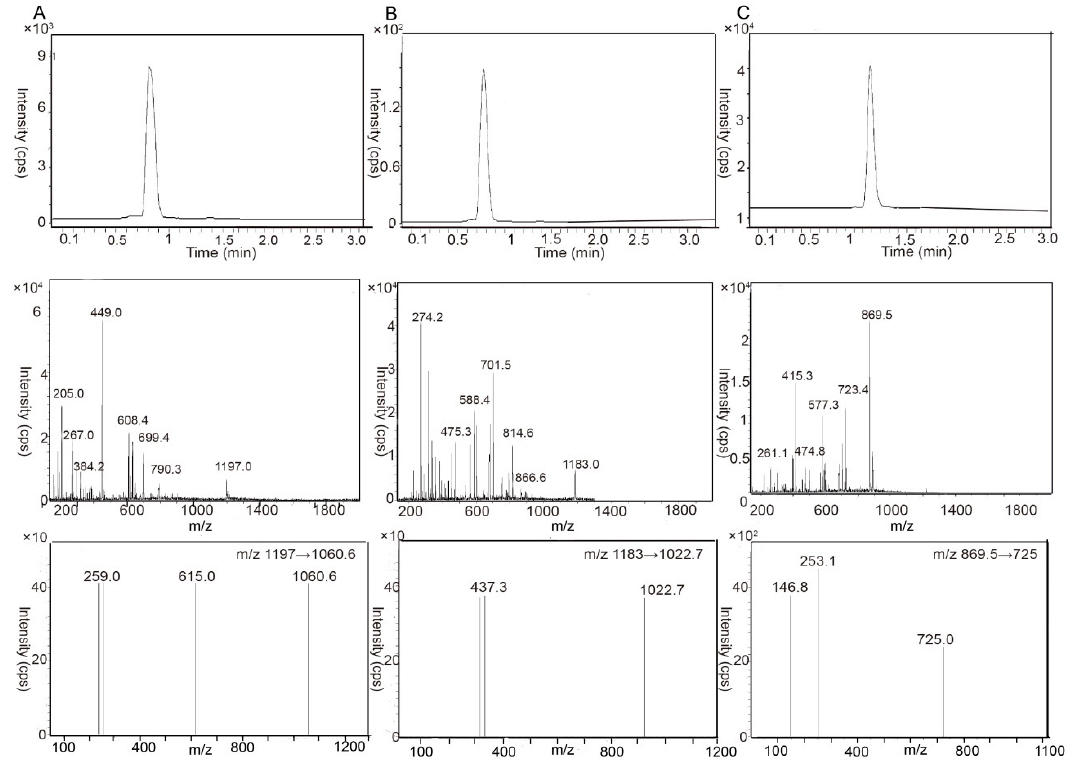
Figure 1. Total ion chromatogram (top panel), product ion mass spectra (middle panel) and the multiple reaction monitoring (MRM) transitions of the deprotonated molecular ions mass spectrogram (bottom panel) of capilliposide B (CAPB, A ), capilliposide C (CAPC, B ) and dioscin (IS, C ). The chromatograms monitoring of CAPB was at m / z 1197.0 → 1060.6, CAPC at m / z 1183.0 → 1022.7 and IS at m / z 869.5 → 725.0.